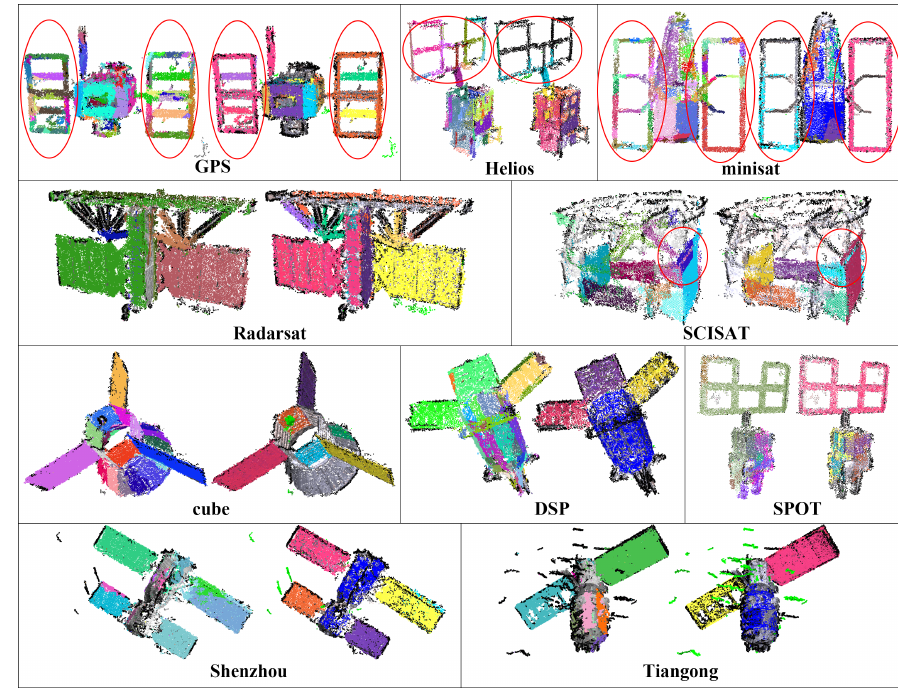
Figure 9. Comparison of plane detection results of [25] (the left ones) and our scheme (the right ones). In [25], no further bounded patch model is generated, and points are rendered in different colors to indicate different planes. For convenience of comparison with [25], the results of ours are rendered in the same pattern. The main differences are marked with red